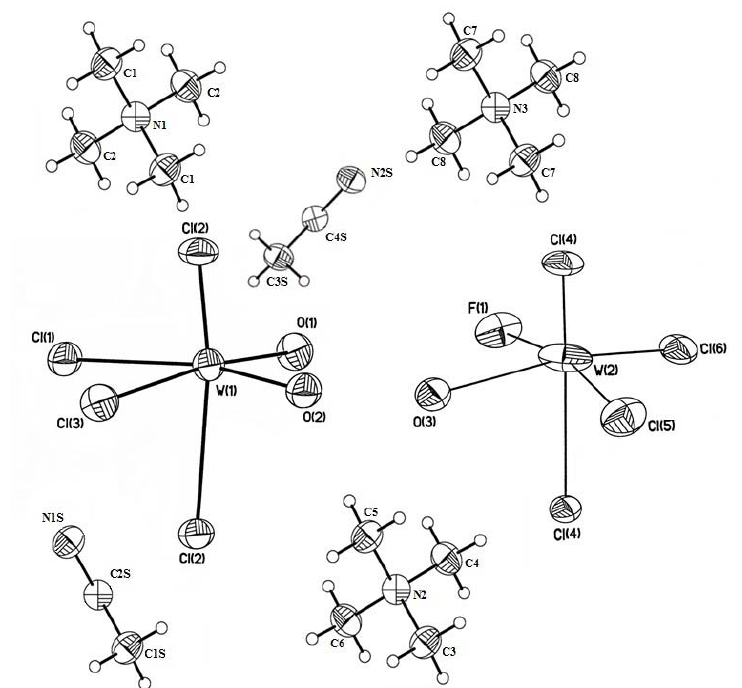
O ] -3 , [WCl FO] - and three independent [N(CH 4 2 4